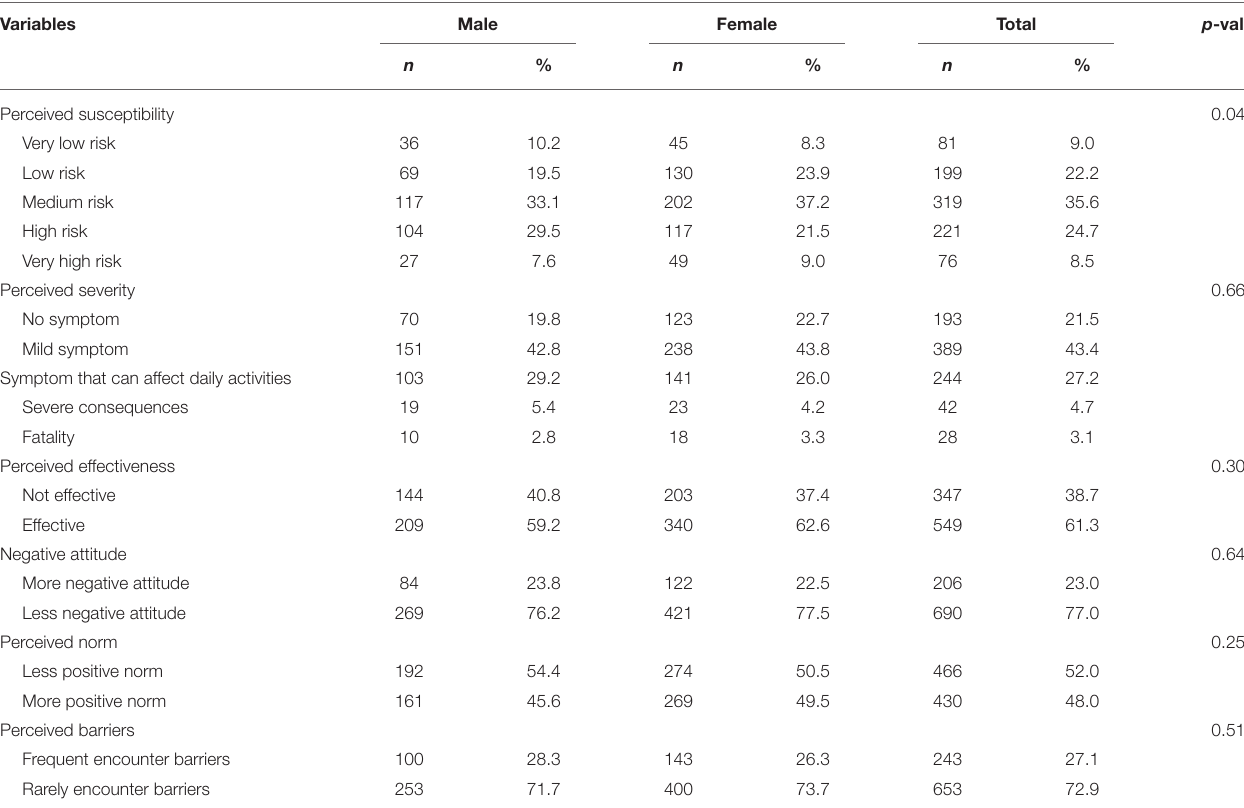
TABLE 3 | Respondents’ perceptions toward hand washing behavior as preventive measure to contract COVID-19. Variables